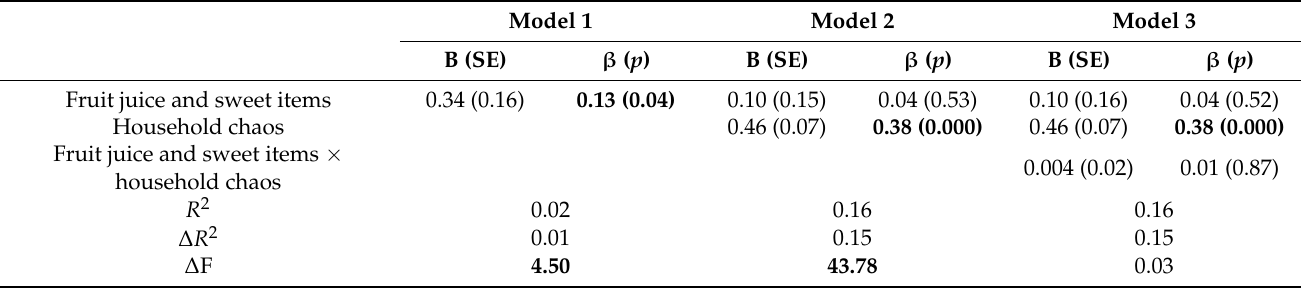
Table 8. Multiple Regression Analyzing Associations Between Fruit Juice and Sweet Items, Household Chaos, and Emergent Metacognition Index (EMI).